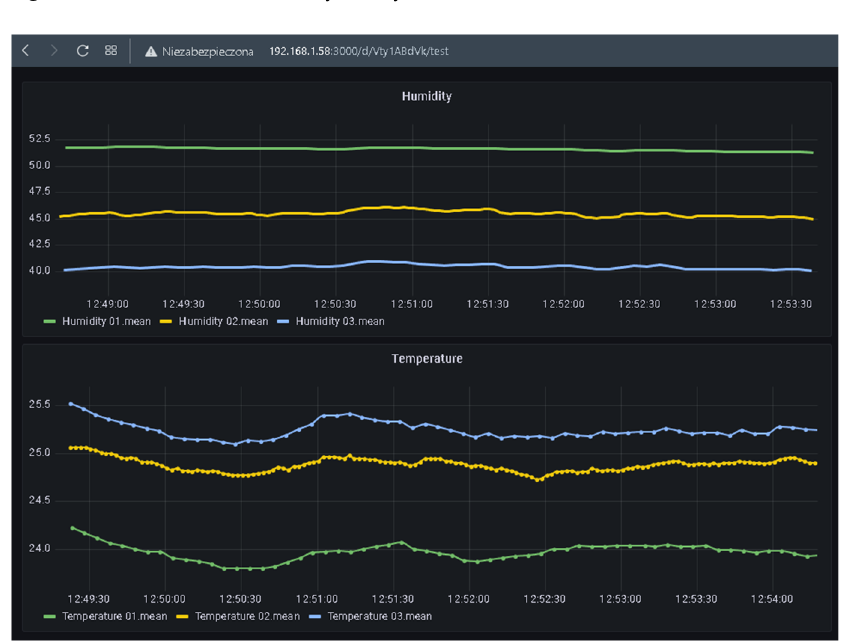
Figure 9. Grafana, own study A. Wycisk.